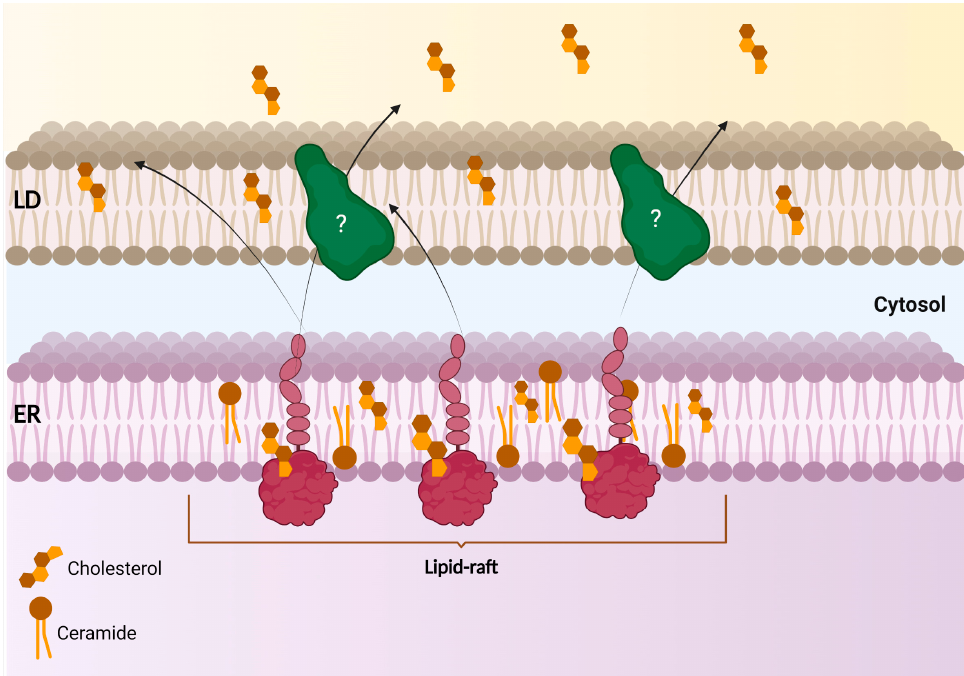
Figure 4. Scheme of S1R at the ER-LD contact site and its activity in lipid export from the ER and compartmentalization within LDs. S1R-enriched lipid raft at the ER controls lipid compartmentalization and export from the ER to lipid droplets.